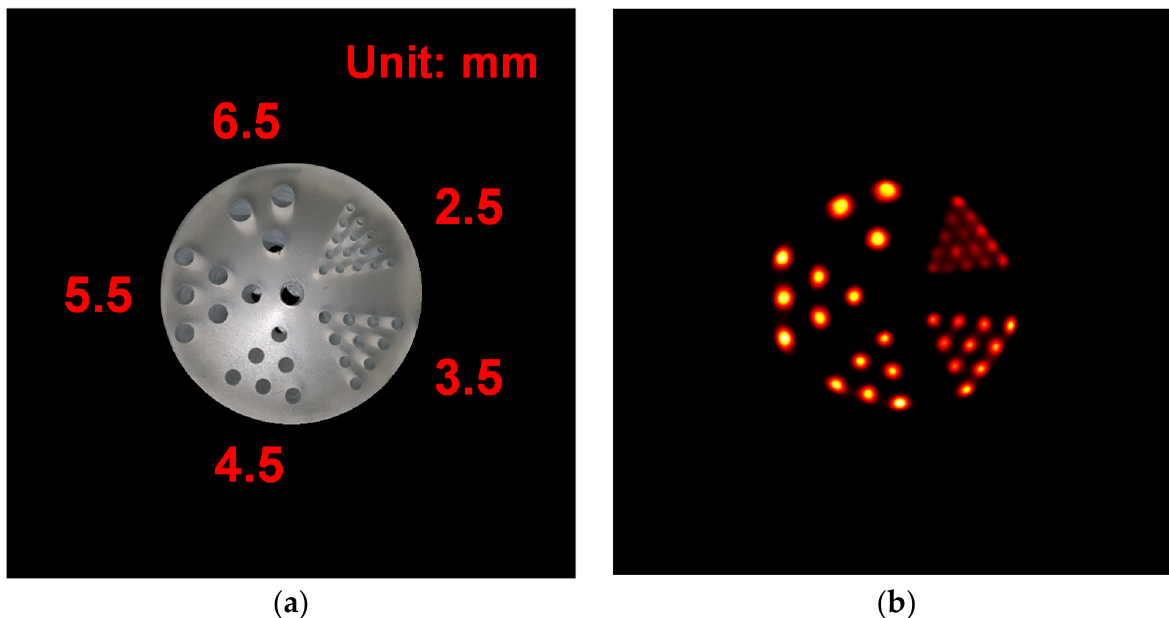
Figure 12. ( a ) Photograph of the hot-rod phantom comprising 40 rods with different diameters (2.5, 3.5, 4.5, 5.5, and 6.5 mm). ( b ) Transverse slice of the hot-rod phantom image acquired using the TOF brain PET.